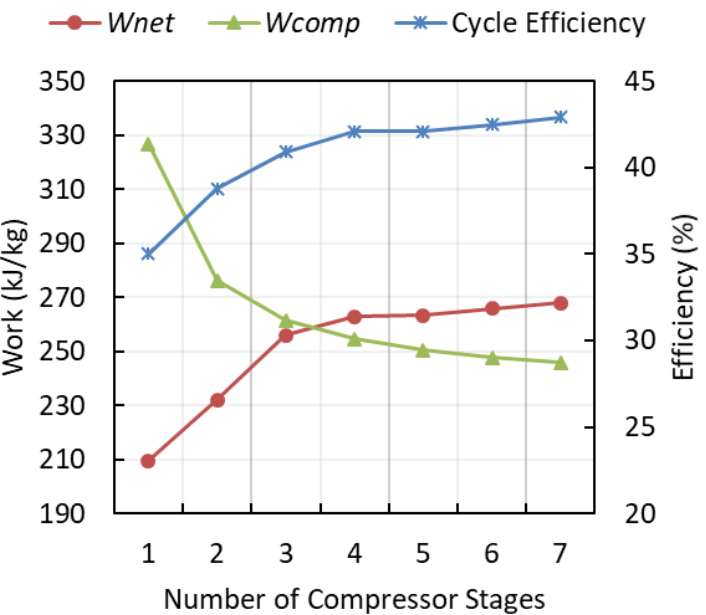
Figure 13. Variation of the compressor work, the net specific work, and the cycle efficiency with the number of compressor stages.